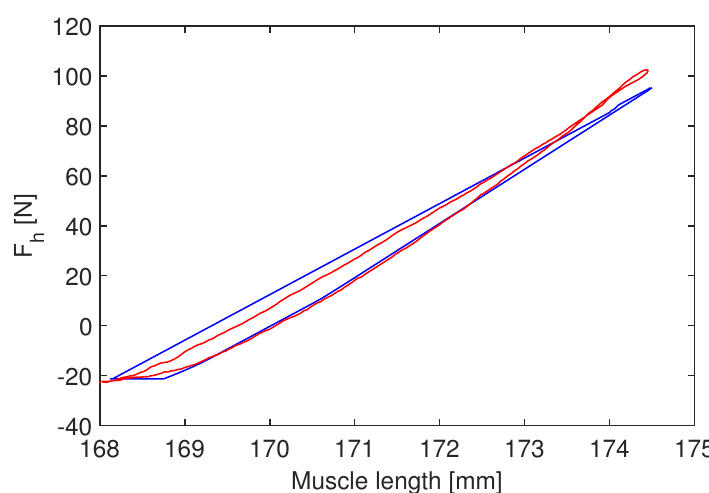
Figure 6. Hysteresis loops extracted from experimental data (red) and output of the simulated multistate friction model (blue curve).